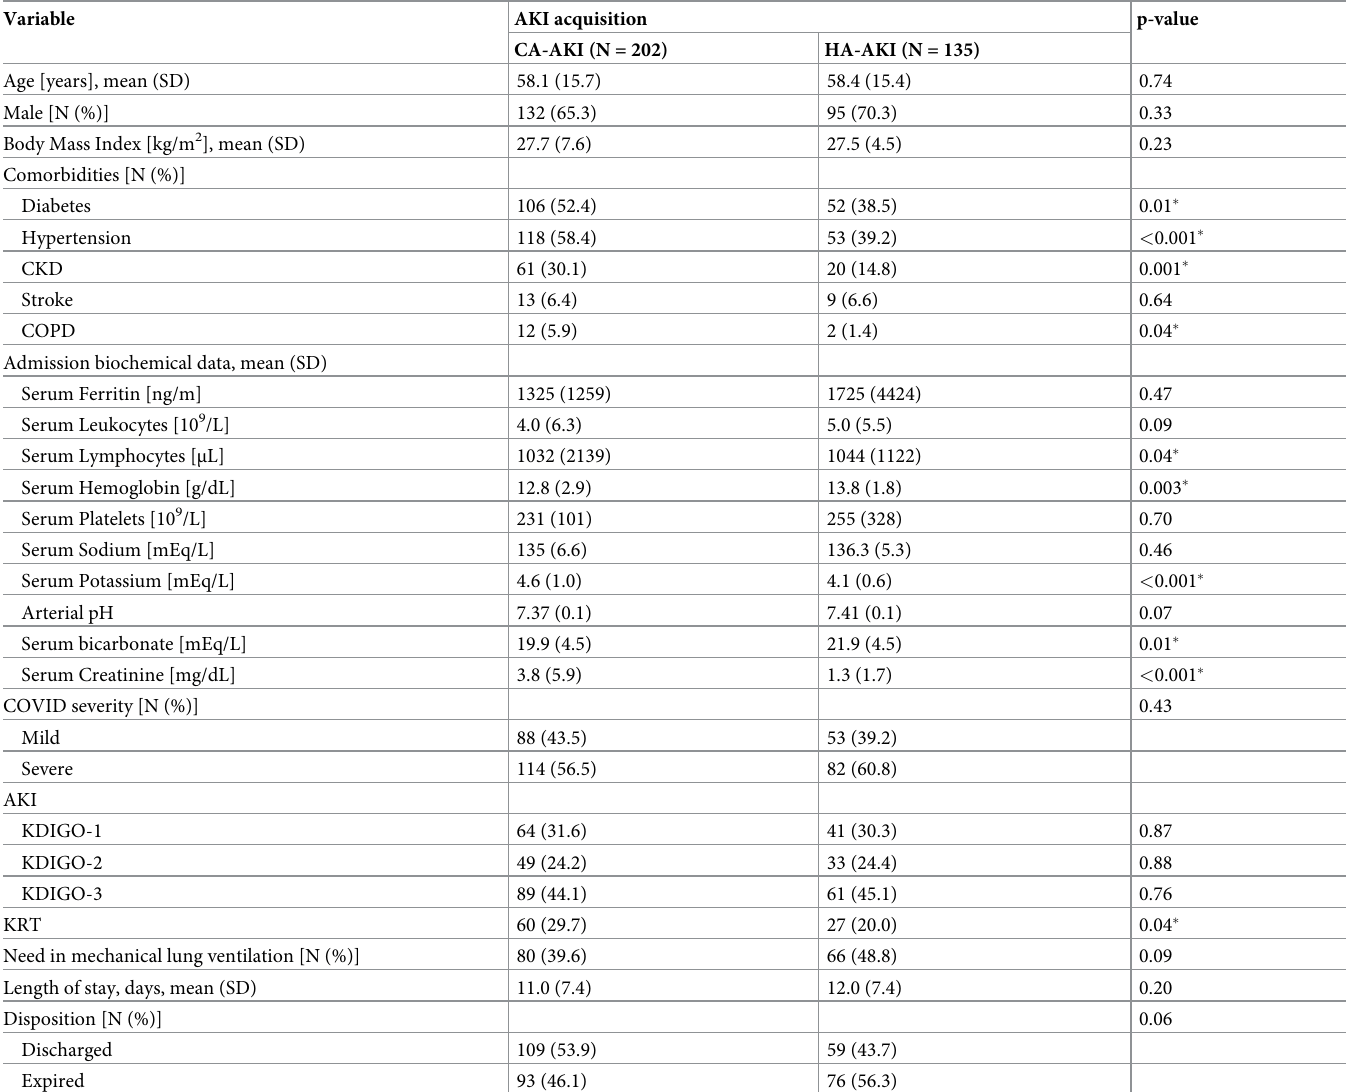
Table 2. Baseline characteristics by AKI